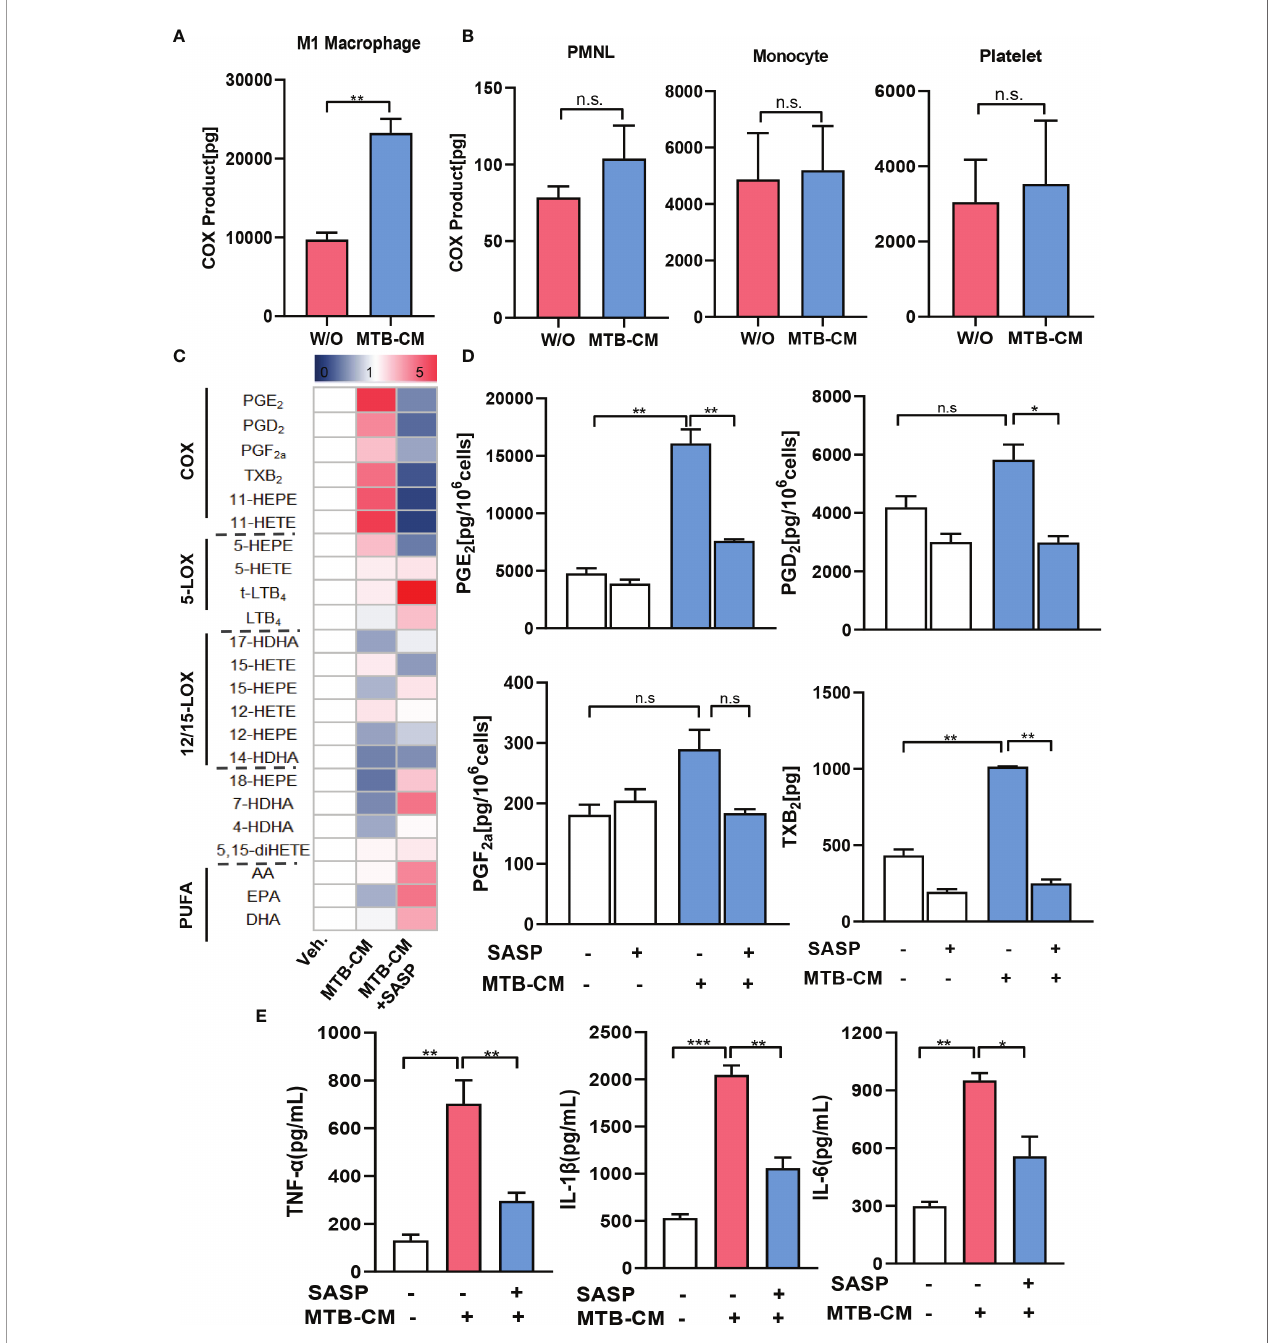
FIGURE 4 | Lipid mediator biosynthesis and cytokine release in M1-MDM exposed to M.tb -conditioned medium (MTB-CM). (A) Human monocytes were differentiated towards M0 GM-CSF MDM and then polarized for 48 h with 100 ng/ml LPS plus 20 ng/ml IFN- g to obtain M1-MDM. (B) PMNL, monocytes and platelets were freshly isolated from human blood. Cells were incubated for 4 h with MTB-CM at 37°C and COX products (PGE 2 , PGD 2 , PGF 2 a , TXB 2 ) released into the culture medium were extracted and analyzed by UPLC-MS-MS. (C) M1-MDM were pretreated with 200 m M SASP or vehicle (veh., 0.1% DMSO) for 1 h and then incubated for 4 h with or without MTB-CM at 37°C. Formed LM were extracted from the supernatants and analyzed by UPLC – MS-MS; detection limit: 0.5 pg. Relative changes of LM given as means, shown in a heatmap, n = 3 separate donors. (D) Absolute values of single COX products (PGE 2 , PGD 2 , PGF 2 a , TXB 2 ) given in pg/ml; data are means ± S.E.M., n =3. Data were log-transformed for statistical analysis by paired t test. (E) Analysis of TNF- a , IL-1 b and IL-6 by ELISA given as pg/ml; data are means ± S.E.M., n =3. The differences among groups were compared using one-way ANOVA followed by Tukey ’ s multiple comparison test *P<0.05, **P < 0.01, ***p ≤ 0.001. n.s., not signi fi